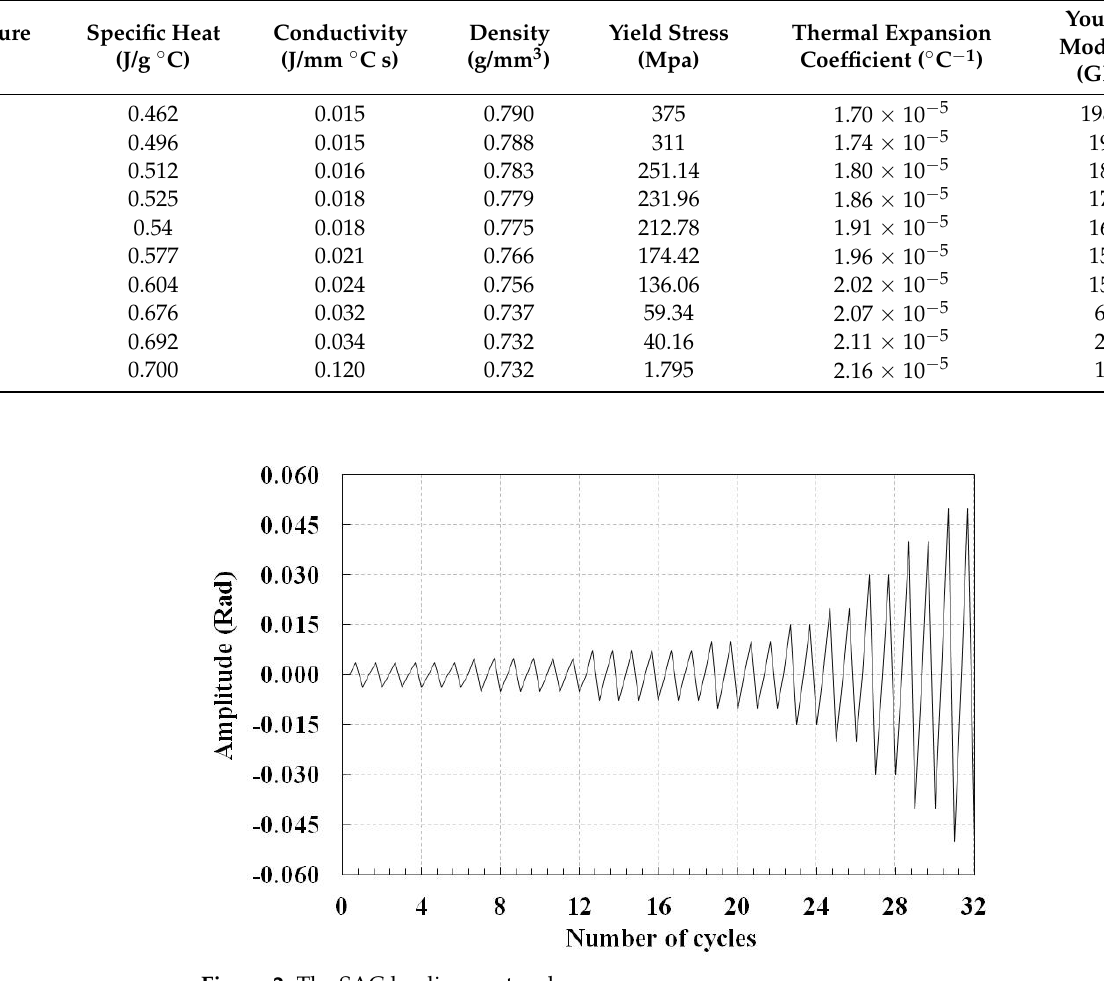
Figure 2. The SAC loading protocol. Figure 2 . The SAC loading protocol .